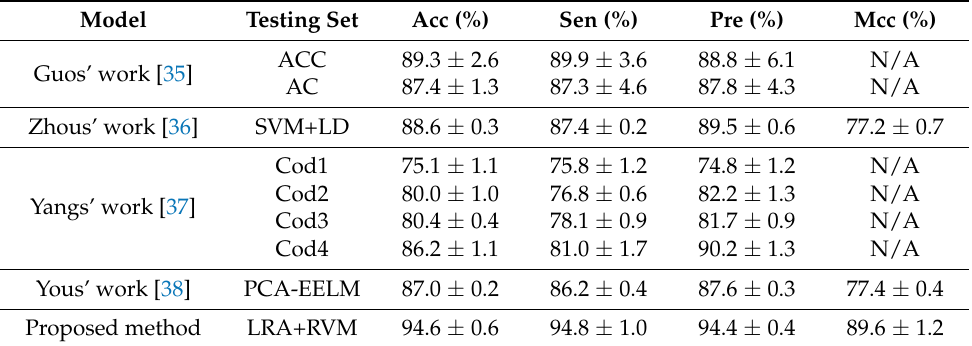
Table 2. The prediction ability of the different methods on the Yeast dataset.